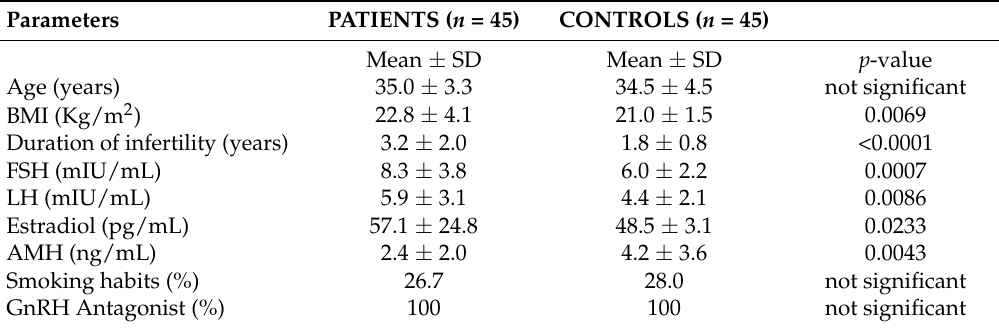
Table 3. Clinical characteristics of 45 infertile patients and 45 age-matched